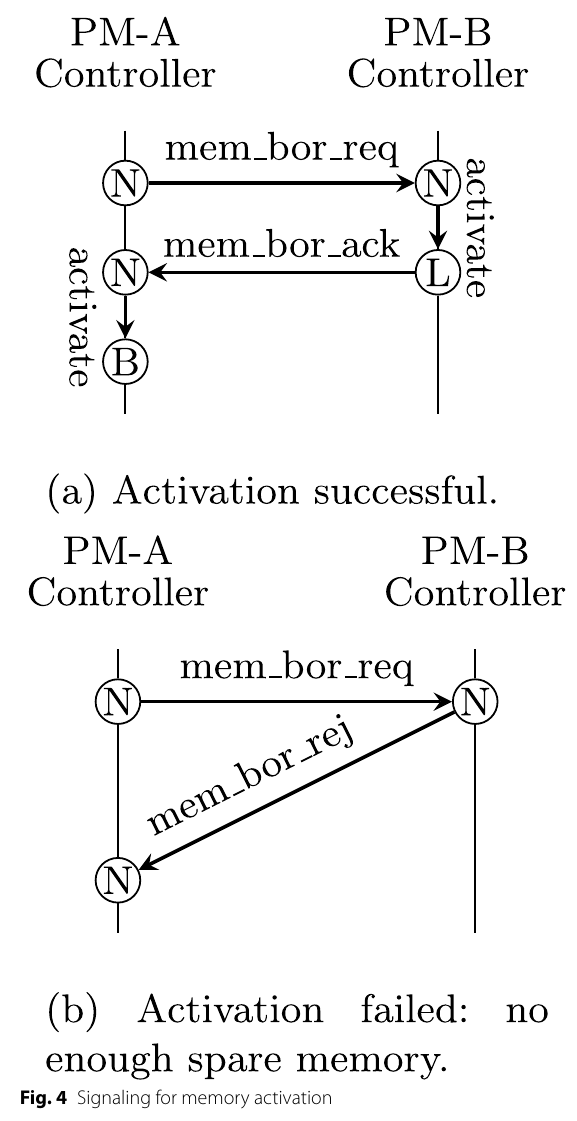
Fig. 4 Signaling for memory